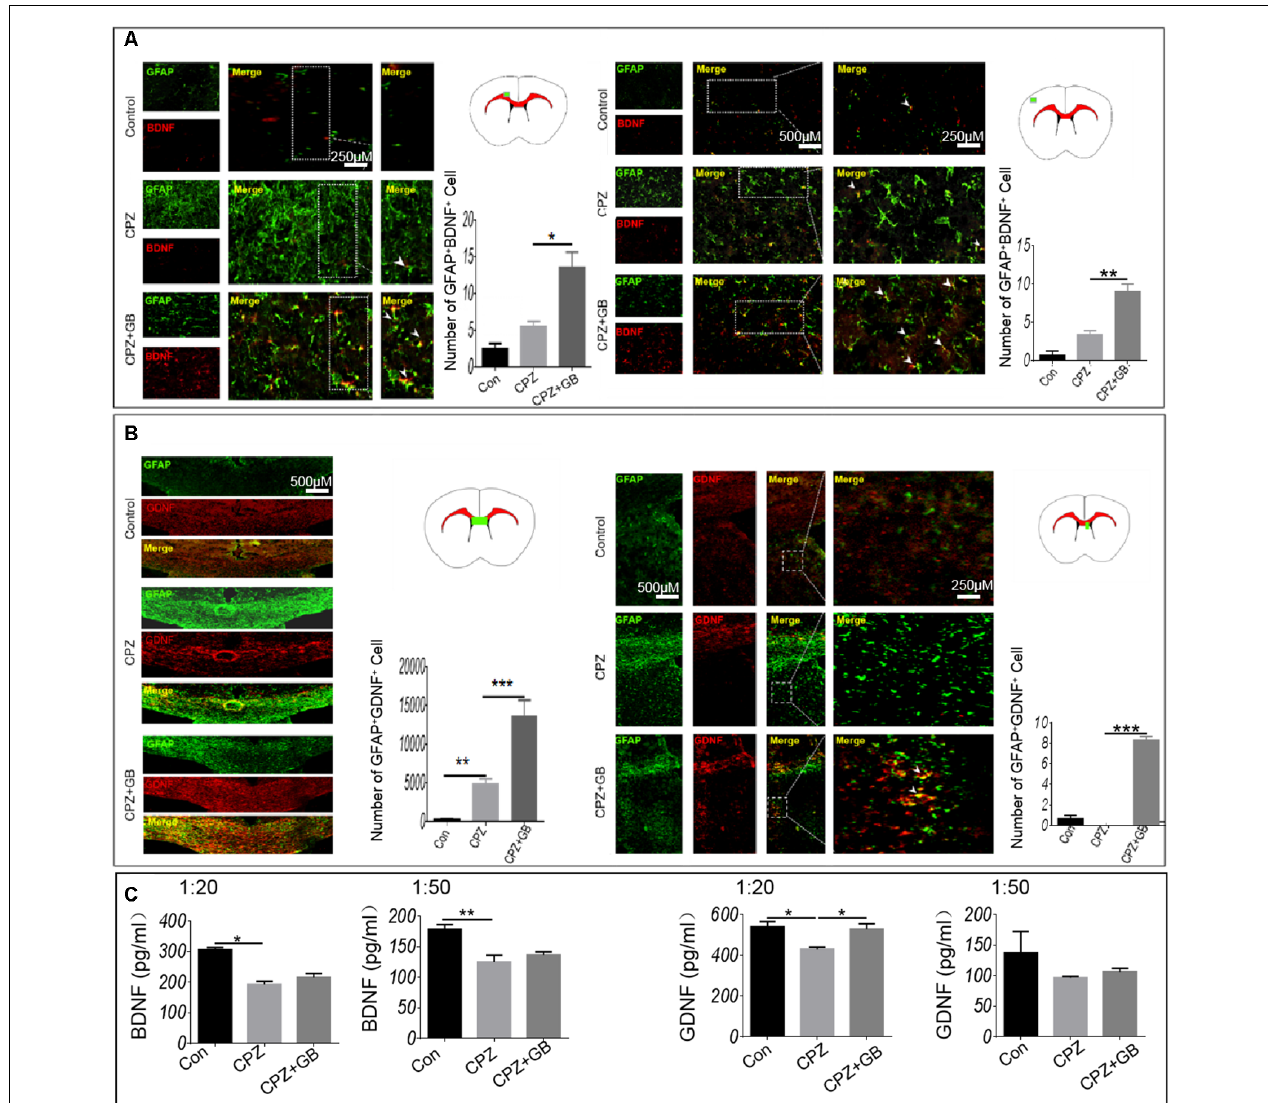
FIGURE 7 | GB induced the production of BDNF and GDNF from astrocytes. Mice were fed with chow containing 0.2% CPZ for 6 weeks and were intraperitoneally injected with GB for 14 consecutive days from the 4th to 6th week of CPZ feeding. (A) Double immunohistochemical staining with anti-GFAP and anti-BDNF in the cingulate cortex and cortex, (B) double immunohistochemical staining with anti-GFAP and anti-GDNF in the corpus callosum and subventricular region. (C) Levels of BDNF and GDNF in the extract of the brain by ELISA. Representative images are obtained from three to four mice/each group, with similar results. The results represent the mean ± SEM. ∗ p < 0.05, ∗∗ p < 0.01, ∗∗∗ p <